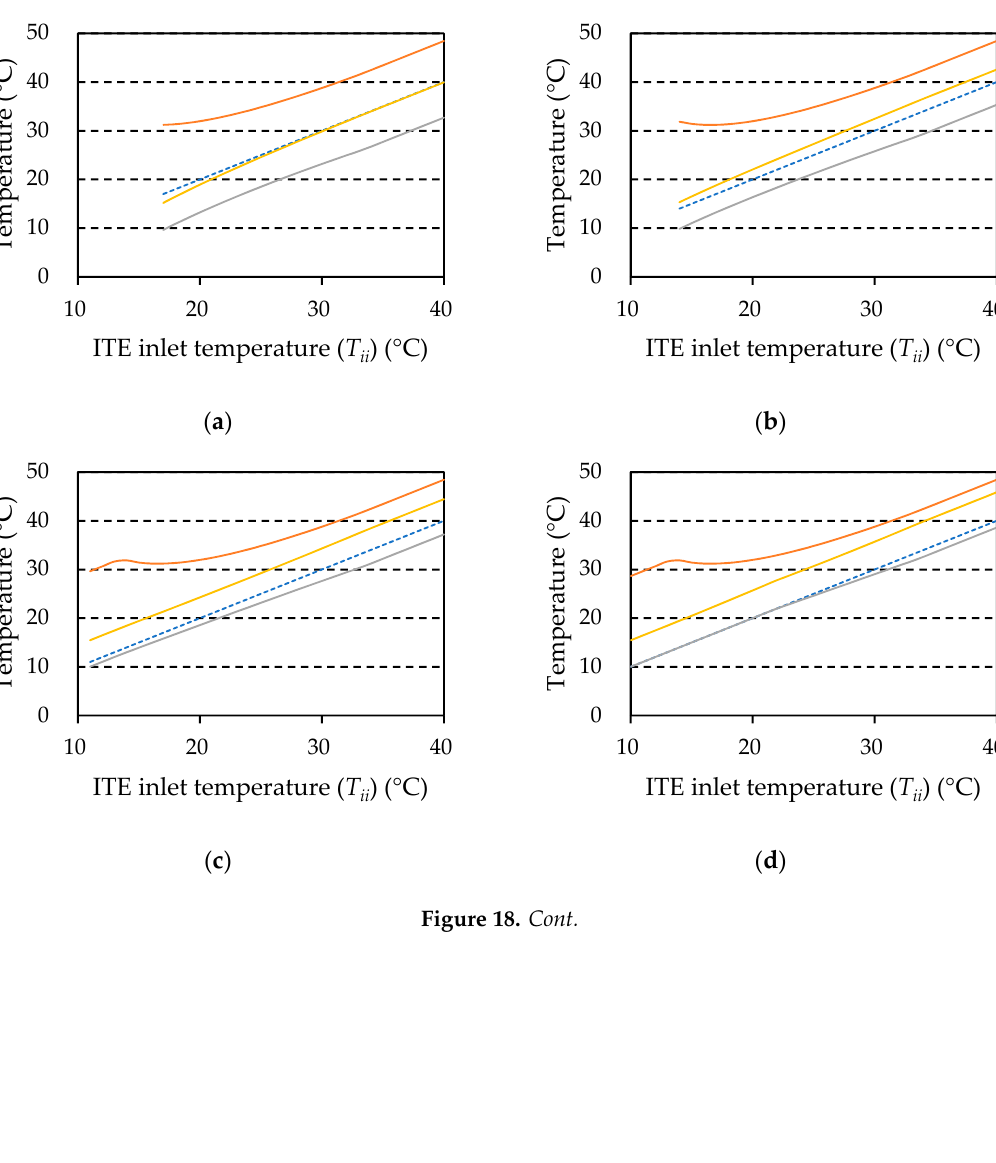
Figure 18. Temperature of each part with respect to ITE inlet temperature ( T ii ): ( a ) ASE = 0.5, ( b ) 0.6, ( c ) 0.7, ( d ) 0.8, ( e ) 0.9, and ( f ) 1.0.